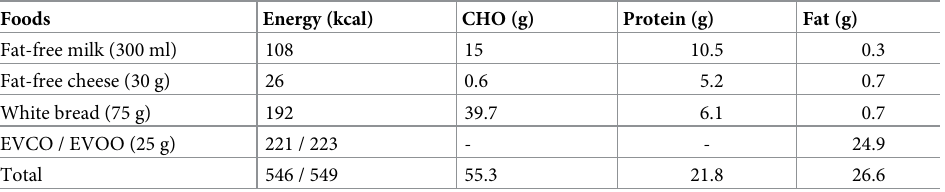
Table 1. Energy and macro nutrients composition of test breakfast meals.